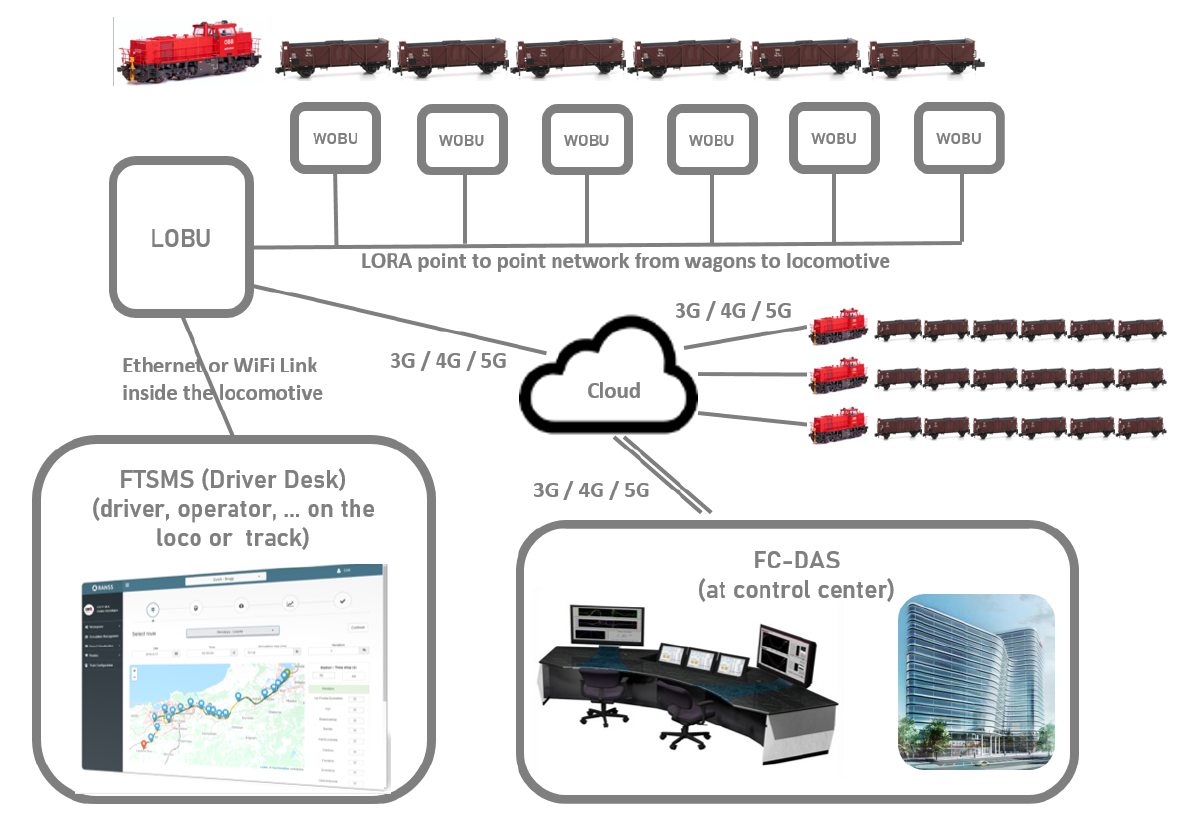
Figure 2. Full digital system integration of the freight railway